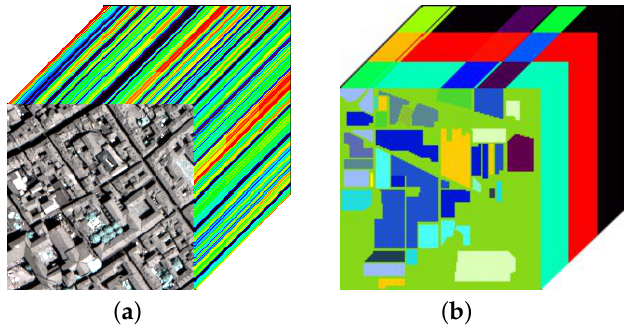
Figure 2. ( a ) Pavia City Center dataset, ( b ) USGS Indian Pines